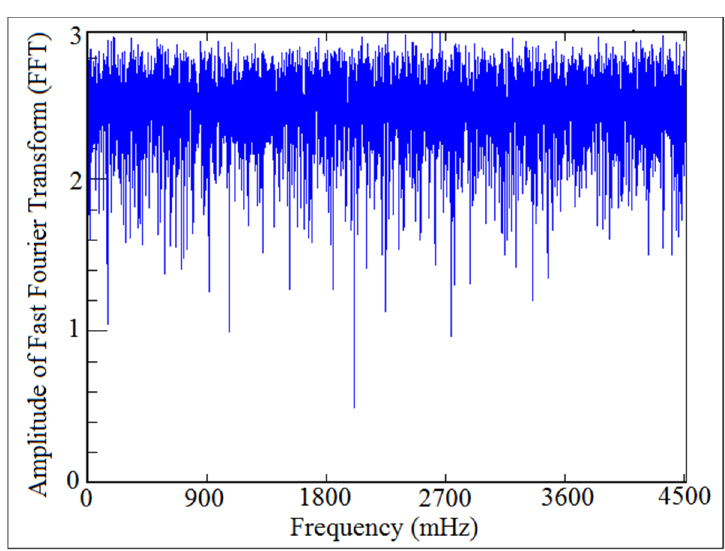
Figure 35. Power density function of the numerical simulation.